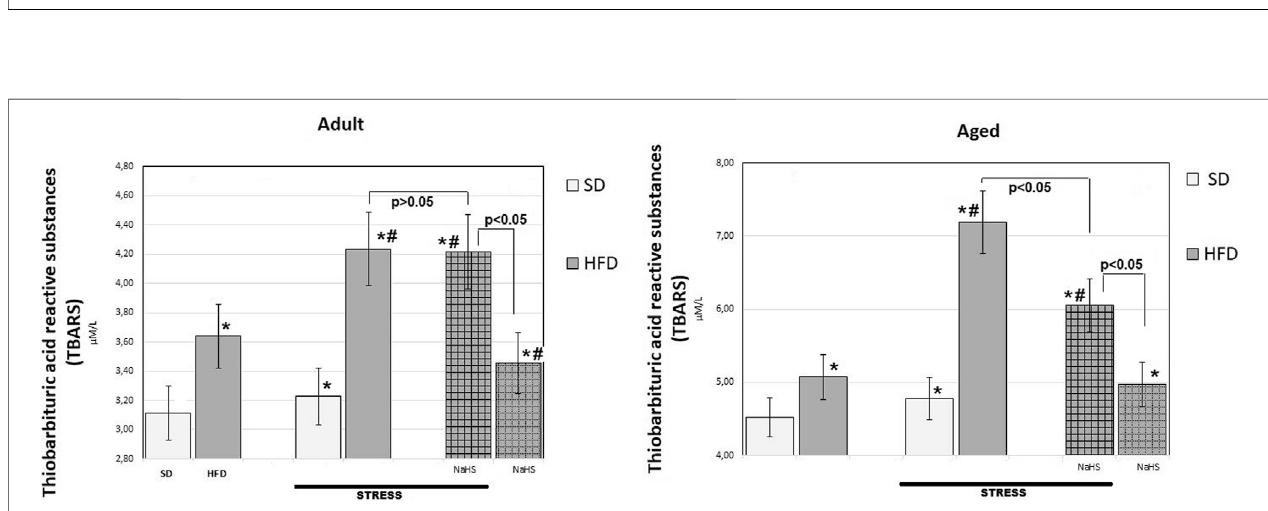
FIGURE 5 | TBARS levels in adult and aged rats fed with a standard diet (SD) or high fructose diet (HFD) without and with H 2 S releasing therapy (NaHS) and induction of acute stress ( n (cid:1) 6); * p < 0.05 vs. SD; # p < 0.05 vs. HFD.